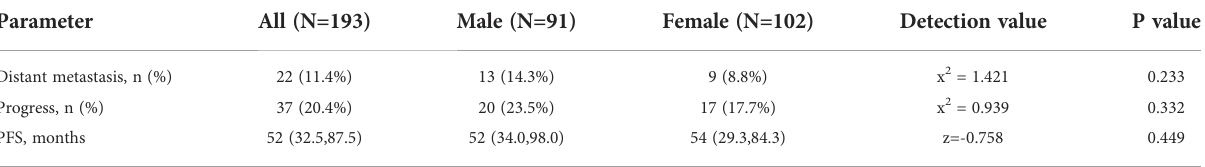
TABLE 3 Gender differences in distant metastasis and prognosis.